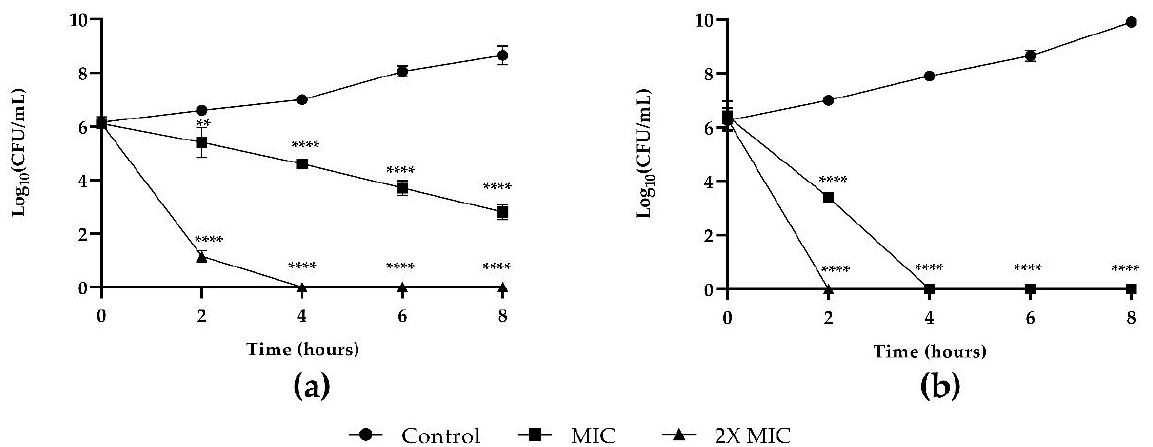
Figure 1. Time to kill of MYR against C. auris and K. pneumoniae : ( a ) growth curves generated using C. auris cells treated with 50 µ g mL − 1 (MIC) and 100 µ g mL − 1 (2 × MIC) of MYR and ( b ) growth curves generated using K. pneumoniae cells treated with 200 µ g mL − 1 (MIC) and 400 µ g mL − 1 (2 × MIC) of MYR ** = p < 0.01, **** = p < 0.0001 (Dunnett’s